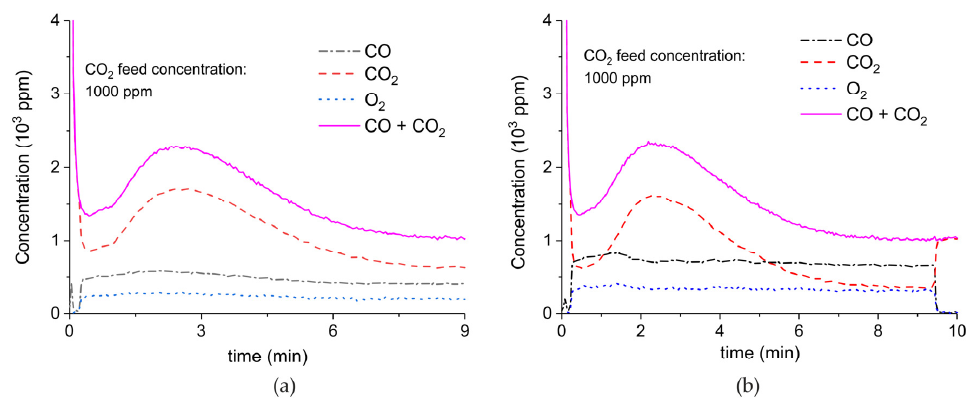
Figure A6. Concentration of the products of CaCO 3 decomposition (sample C) as function of time at 630 °C, flow rate of 90 mL/min. The fed CO 2 concentration is 0 ppm and the plasma power is 1.5 W ( a ), 2.1 W ( b ), 1.7 W ( c ), 2.2 W ( d ), 1.5 W ( e ), 2 W ( f ), and 1.1 W ( g ). The plasma is applied at the beginning of the reaction. The decomposition cycles are in order #2, #3, #7, #8, #10, #11, #19.